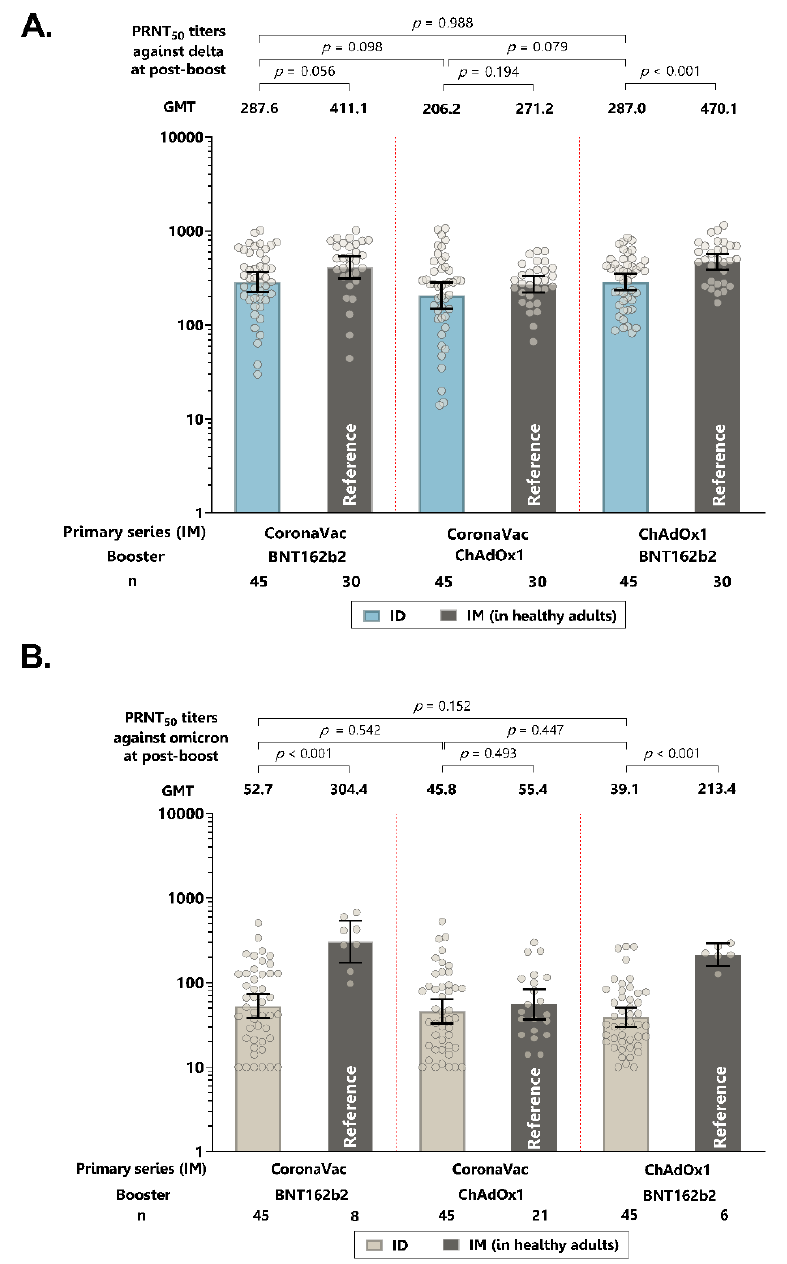
Figure 3. Neutralizing antibody titers of live virus plaque reduction neutralization assays (PRNT 50 ) against delta strain ( A ) and omicron strains ( B ) following intradermal (ID) booster. Intramuscular (IM) boosting of the similar vaccine regimens from the previous study [19] is included as the reference group. Error bars represent geometric mean titers plus 95% confidence intervals.